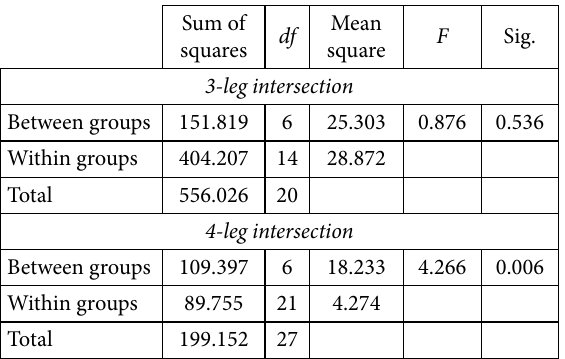
Table 5. ANOVA per days per week